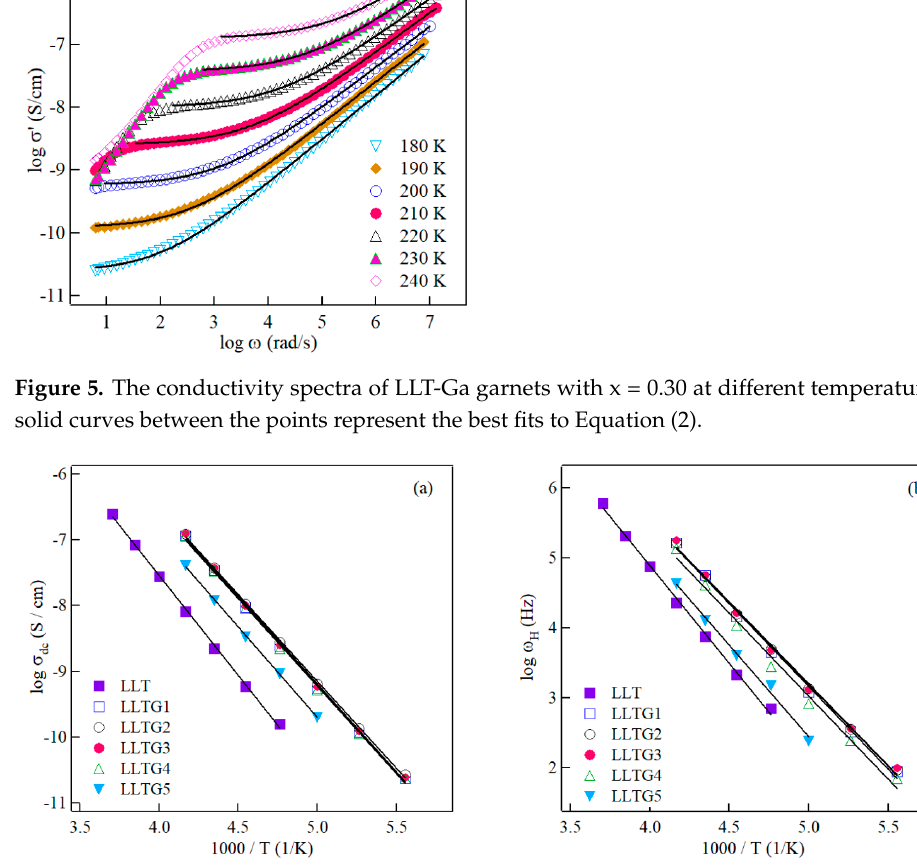
Figure 6. ( a ) The temperature dependence of the dc conductivity, σ dc , and ( b ) the hopping frequency, ω H , as determined from the fitting process in Figure 5. Table 1. The values of σ dc at 300 K and the activation energy Δ E for ionic conduction of Li 5+2x La 3 Ta 2- x Ga x O 12 garnets. E σ and E H are the activation energy for the conduction and the hopping process, whereas E tan δ is the activation energy of the dielectric relaxation process determined from dissipation factor. n c is the average value of the concentration of Li + mobile ions.